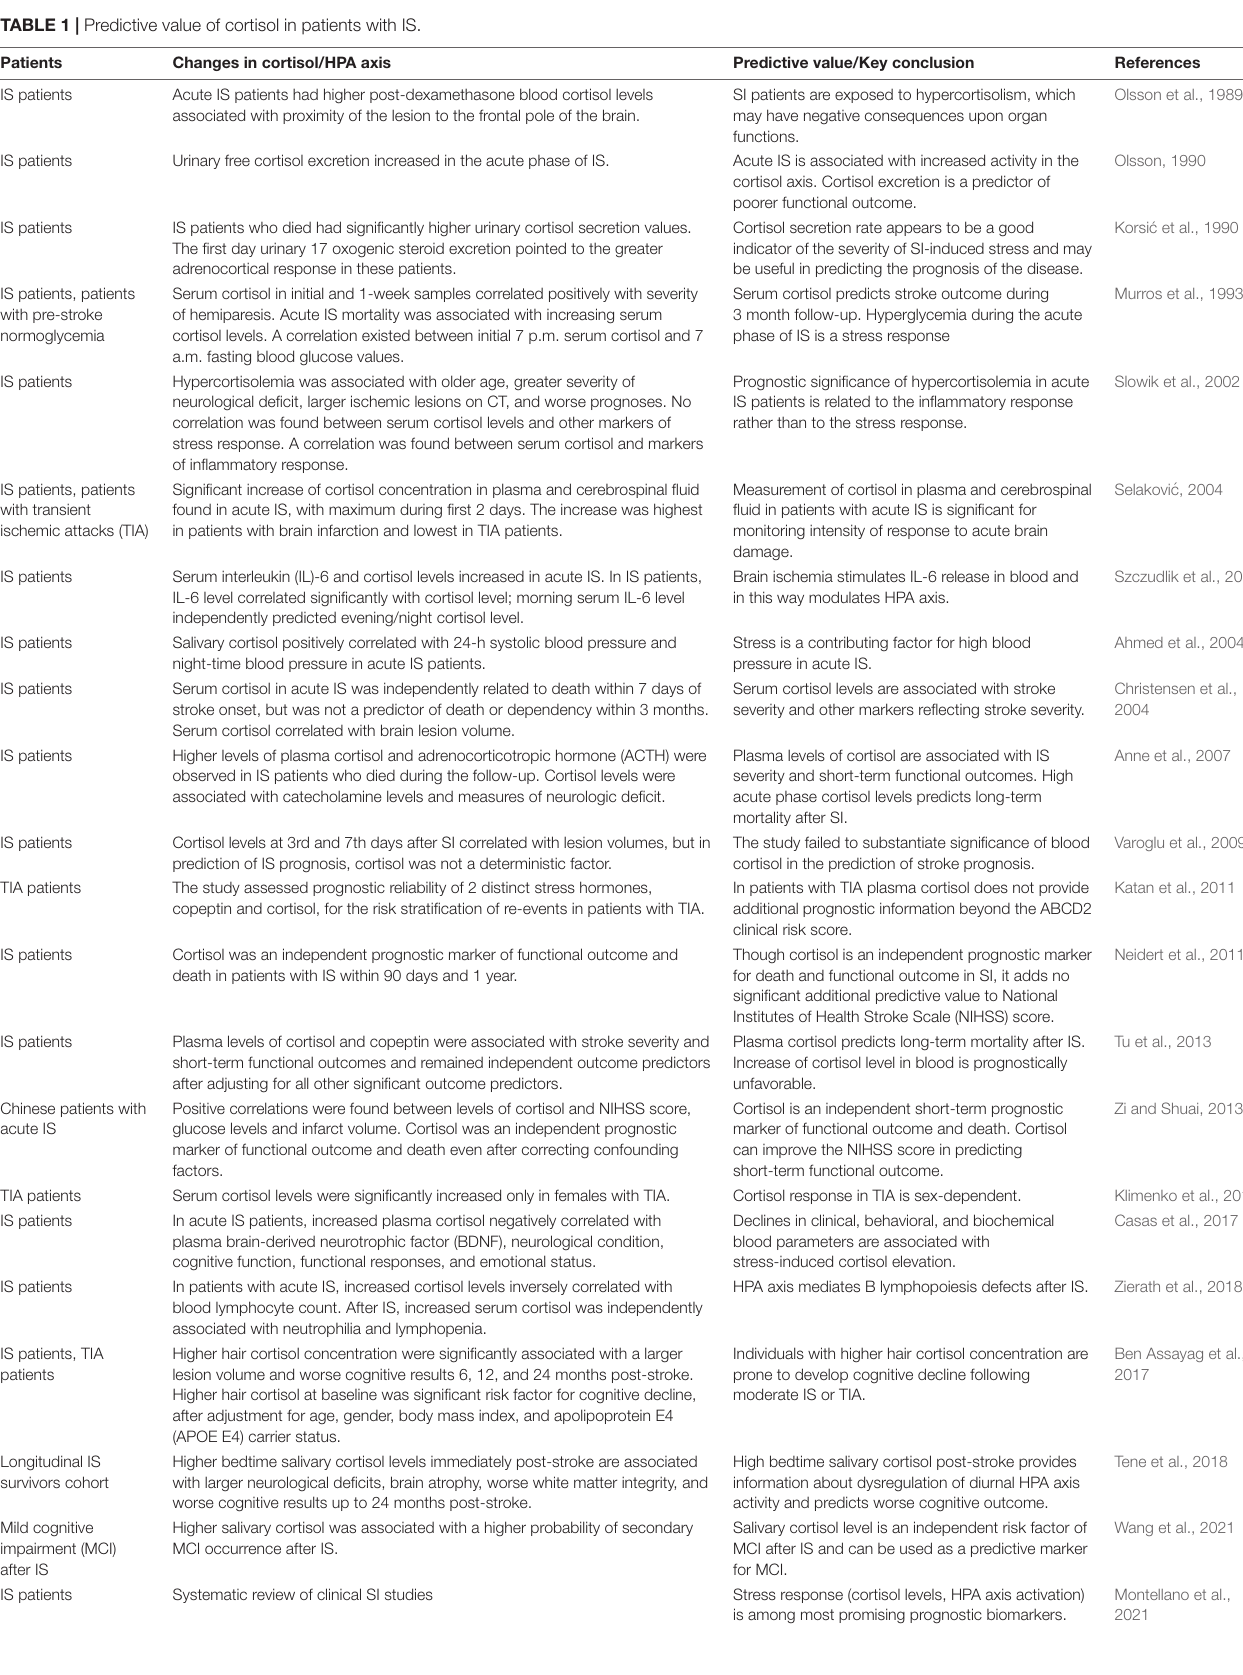
TABLE 1 | Predictive value of cortisol in patients with